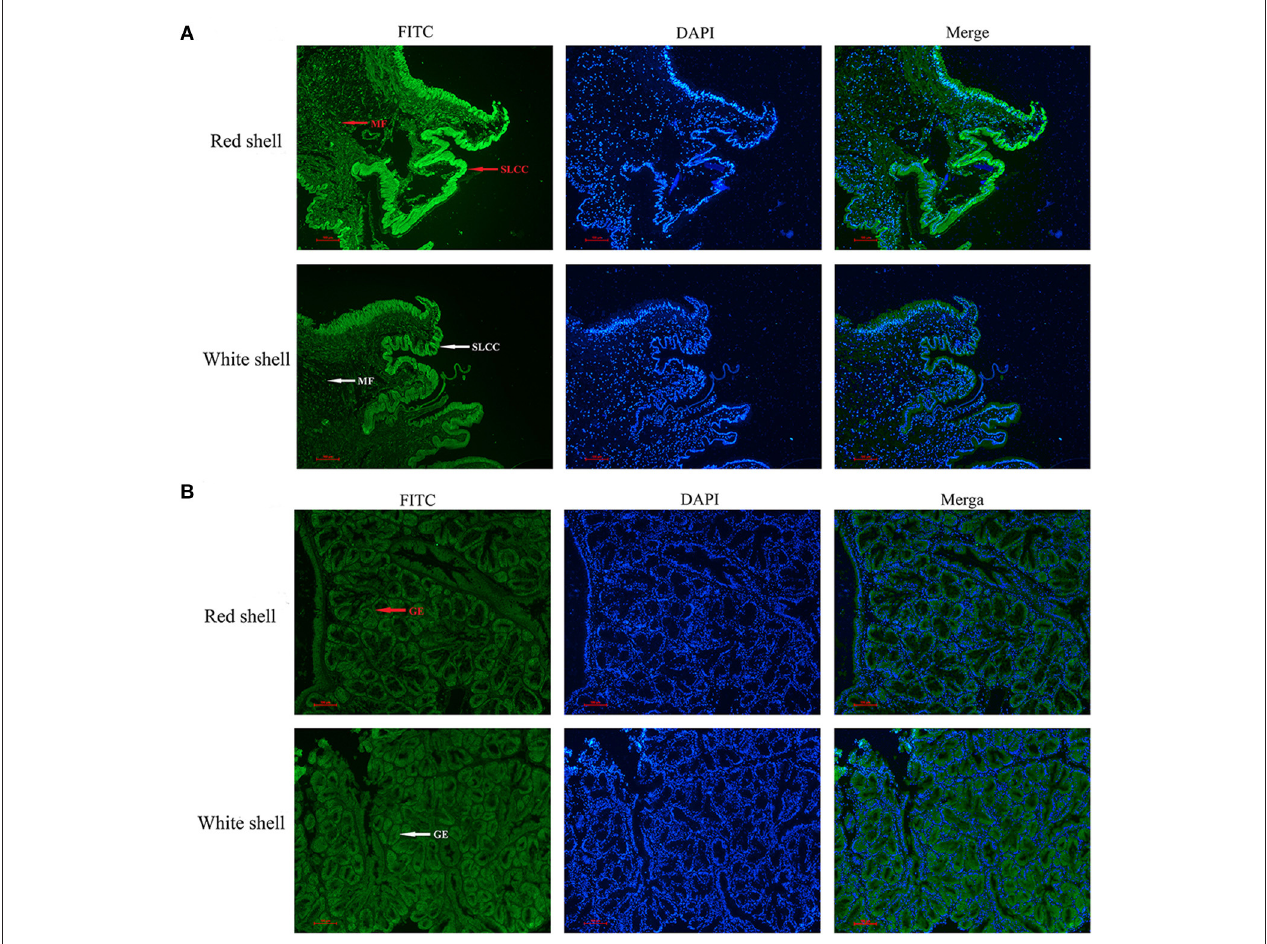
FIGURE 4 | Distribution of BCDO2 in the mantle and digestive gland from red and white shell M. meretrix , respectively. (A) Localization of BCDO2 in single-layer columnar cells (SLCC) and muscle fibers (MF) of the mantle. (B) Localization of BCDO2 in glandular epithelium (GE) of digestive gland. Green fluorescence signal, FITC; blue fluorescence signal,